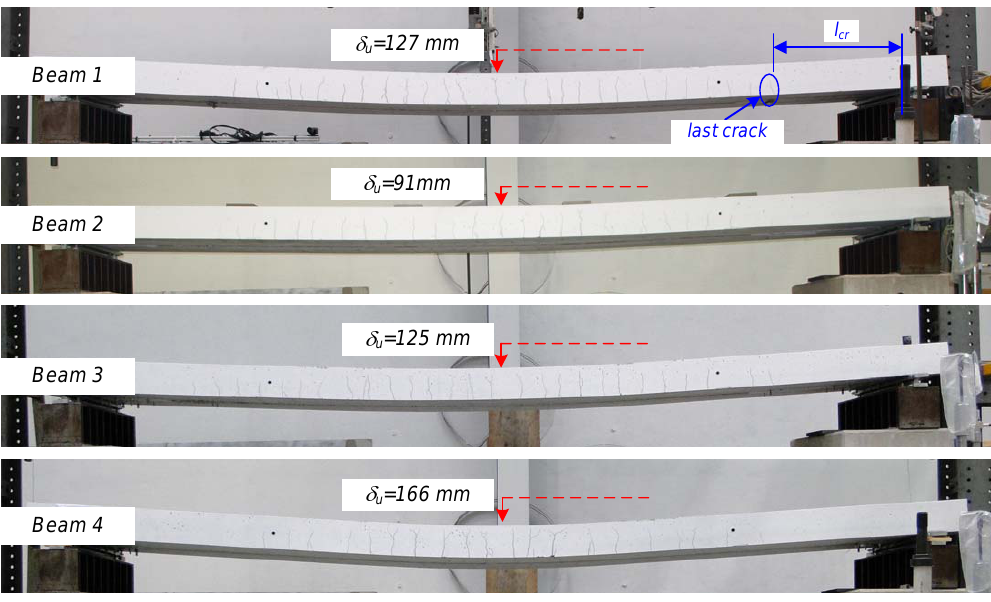
Figure 9. Crack patterns after the test ended of all four beams